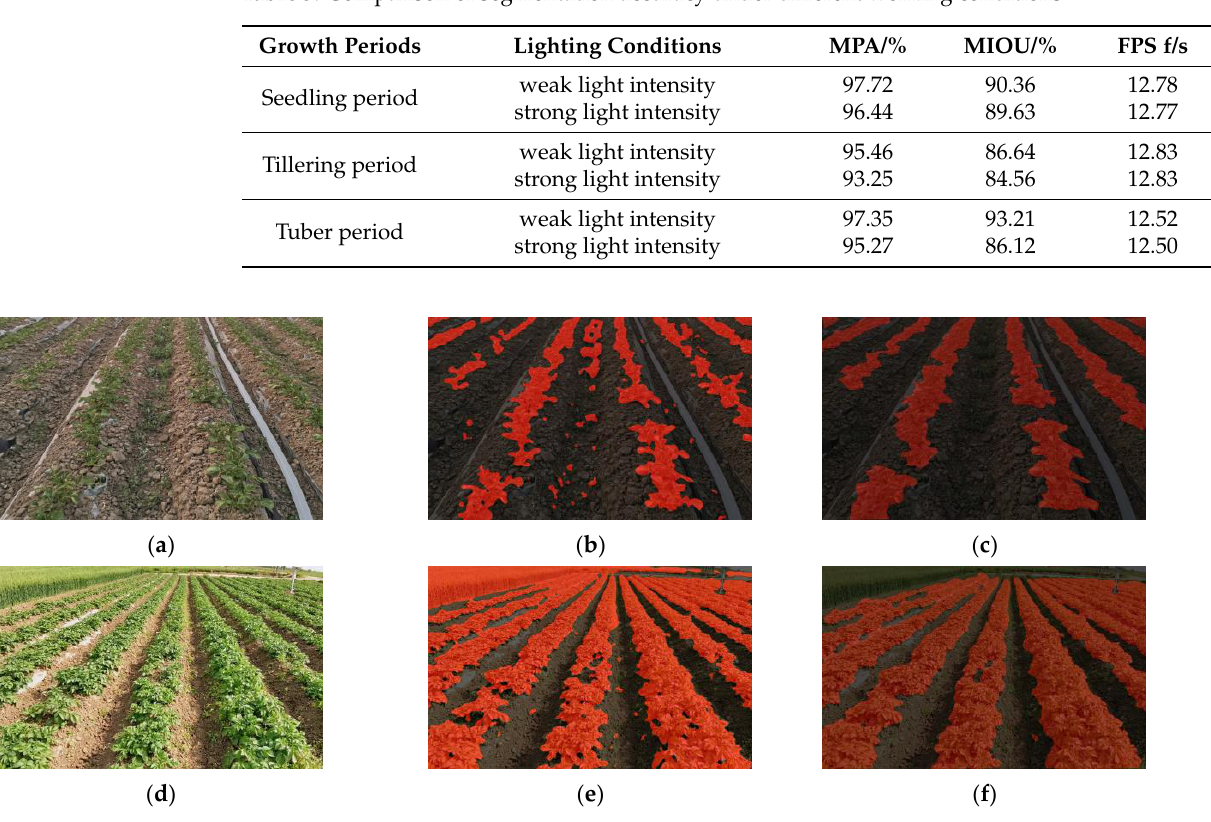
Figure 11. Comparison of traditional image processing and our method under weed interference ( a , d ) RGB images; ( b , e ) traditional methods; ( c , f ) our method.